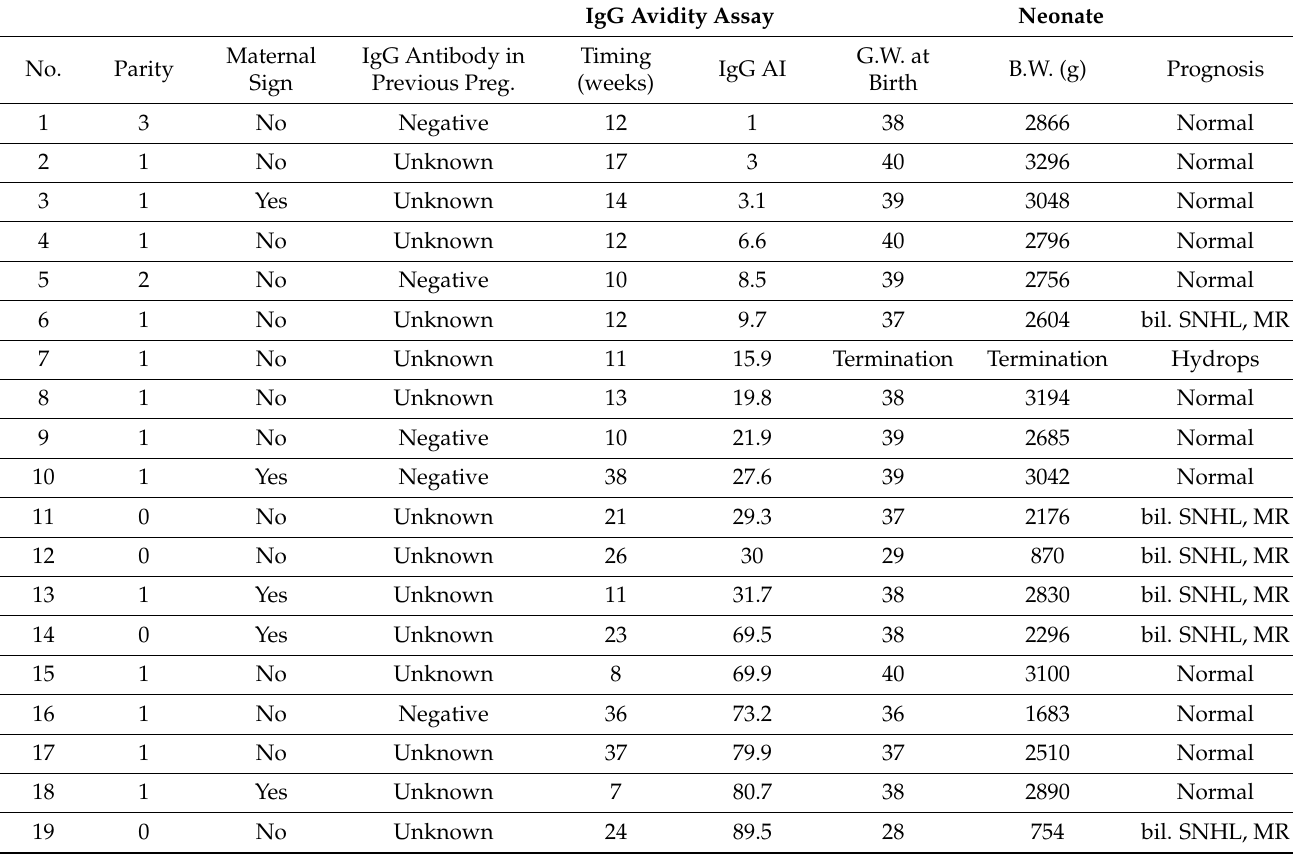
Table 2. Characteristics of CMV-infected cases.